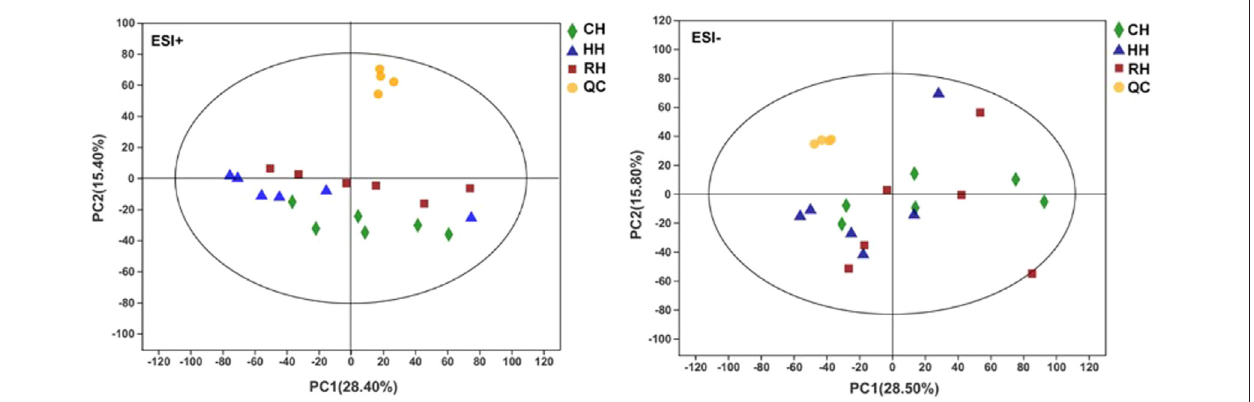
FIGURE 2 | PCA score plot of samples in treatment groups and QC (ESI + , ESI − ).